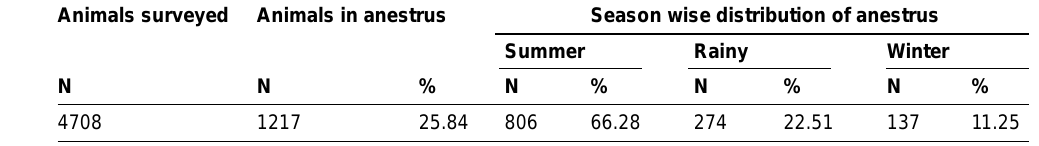
Table-3. Season wise distribution of anestrus in buffaloes in organized farms Animals surveyed